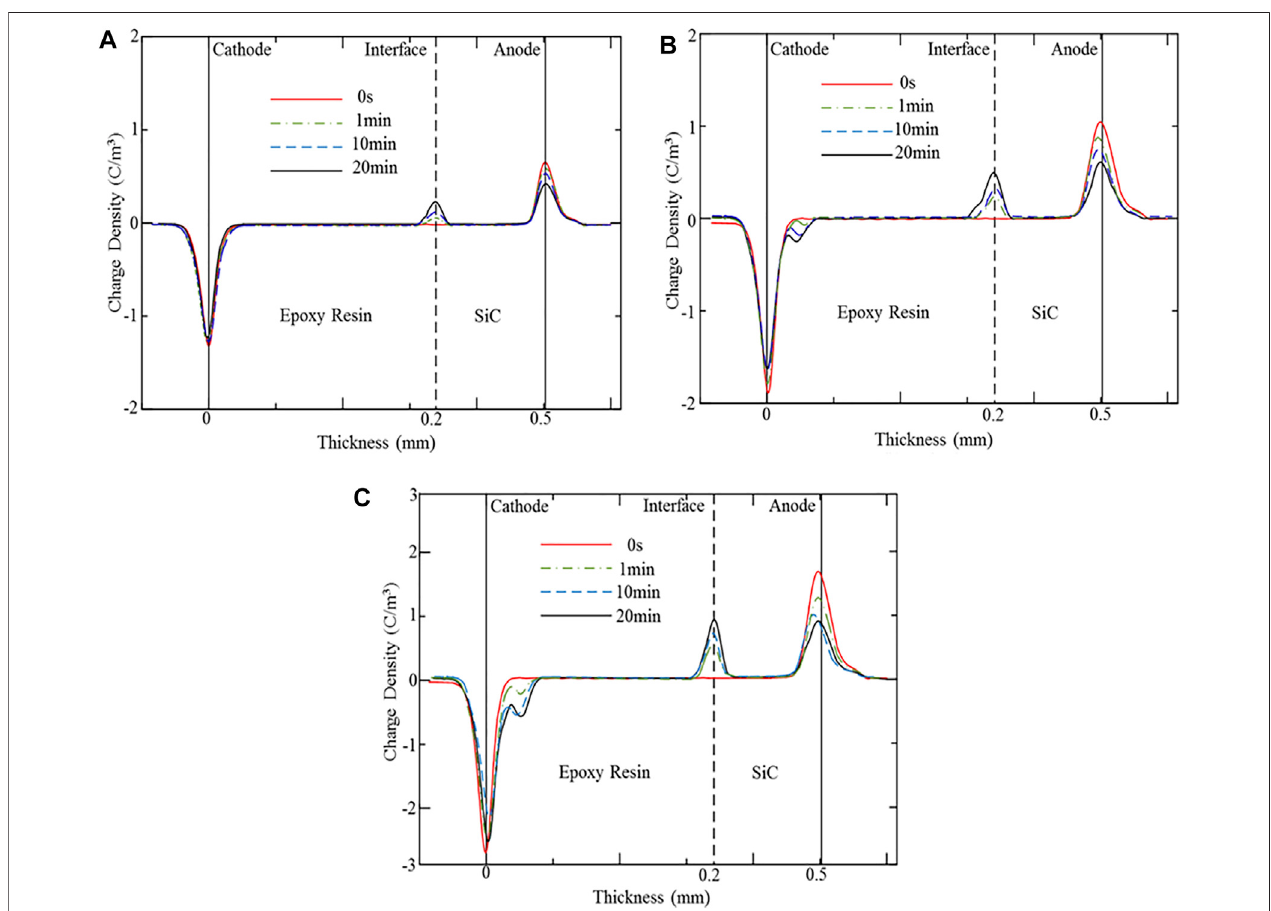
FIGURE 2 | Space charge pro fi les for the SiC – epoxy resin double-layered sample with different polarization time. (A) Space charge distribution at 10 kV/mm. (B) Space charge distribution at 15 kV/mm. (C) Space charge distribution at 20 kV/mm.